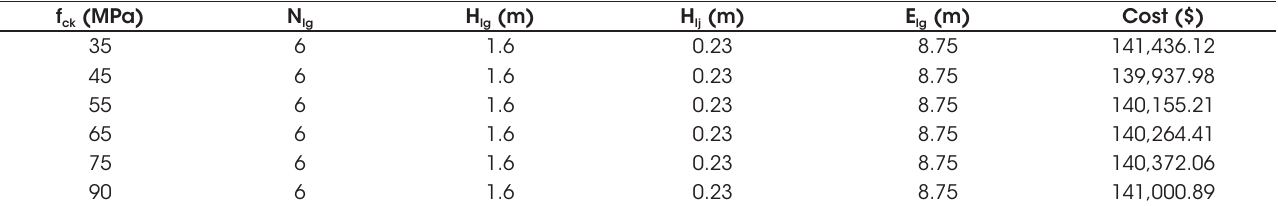
Cost of the deck in function of the characteristic strength of concrete, Group A